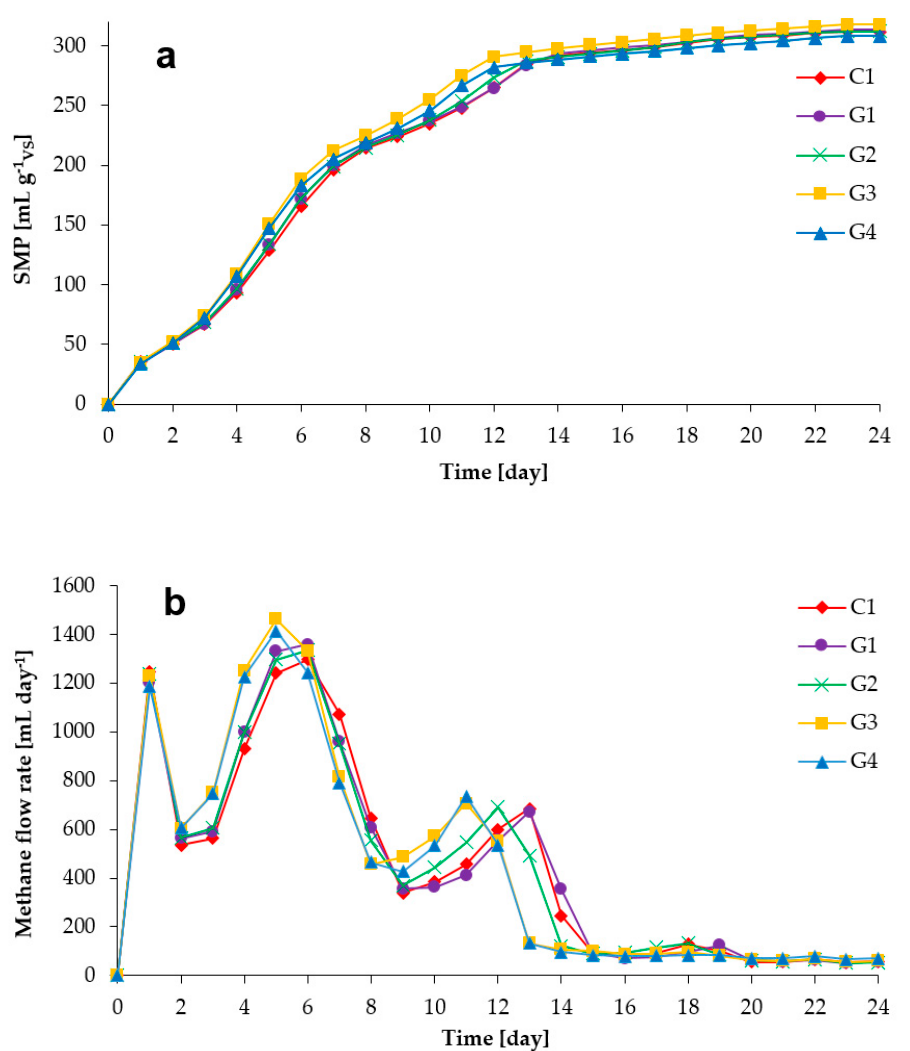
Figure 1. Effects of granular activated carbon (GAC) addition on specific methane production (SMP) ( a ) and methane flow rate ( b ) during the experimental period (inoculum to substrate ratio (ISR) is 1.43). Different concentrations of GAC (0 g L − 1 , 1 g L − 1 , 2 g L − 1 , 5 g L − 1 , and 10 g L − 1 ) were added to reactors (C1, G1, G2, G3, and G4, respectively).